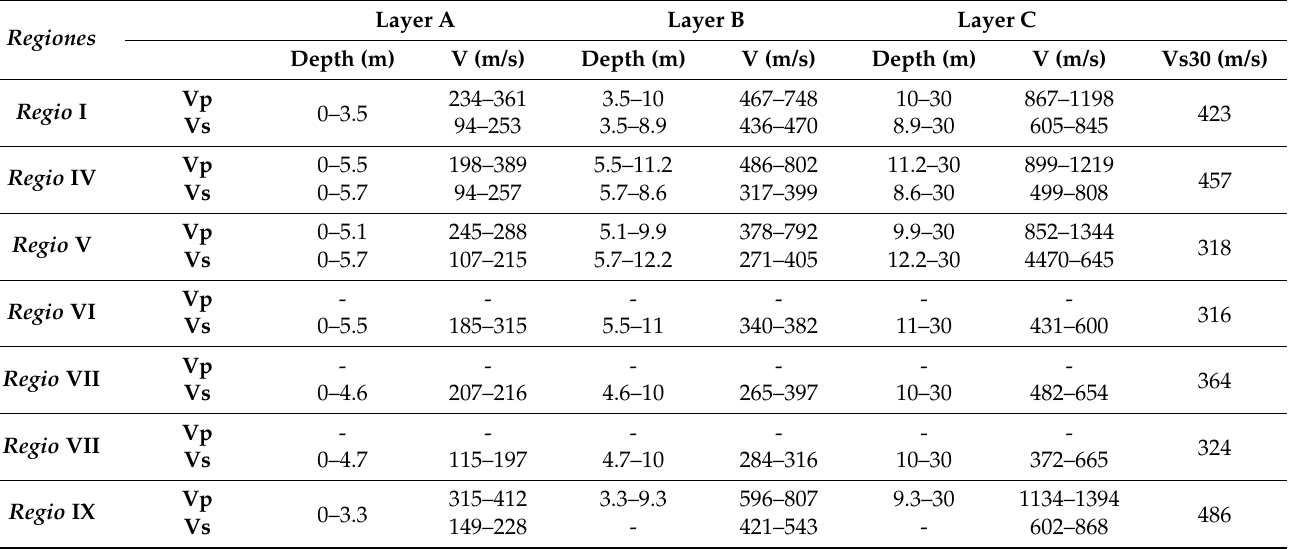
Table 3. Geophysical data and seismostratigraphy of the Pompeii subsoil. Characterization of the Vp and Vs wave velocity and evaluation of the